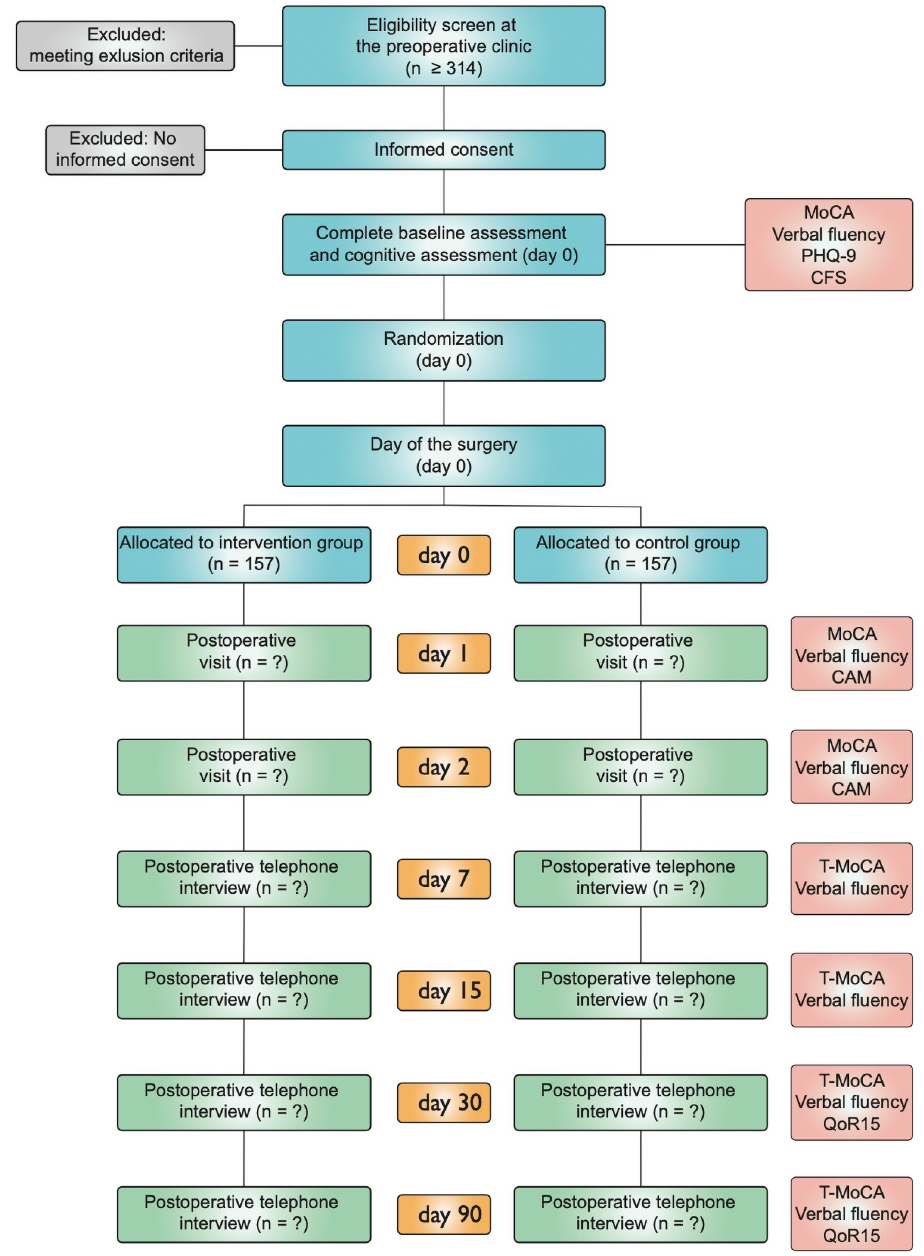
Fig 1. SPIRIT schedule of enrollment, interventions, and assessments. MoCA: Montre´al Cognitive assessment, PHQ-9: Patient Health Questionnaire 9, CAM: Confusion Assessment Method, T-MoCA: Telephone MoCA, QoR15: Quality of Recovery